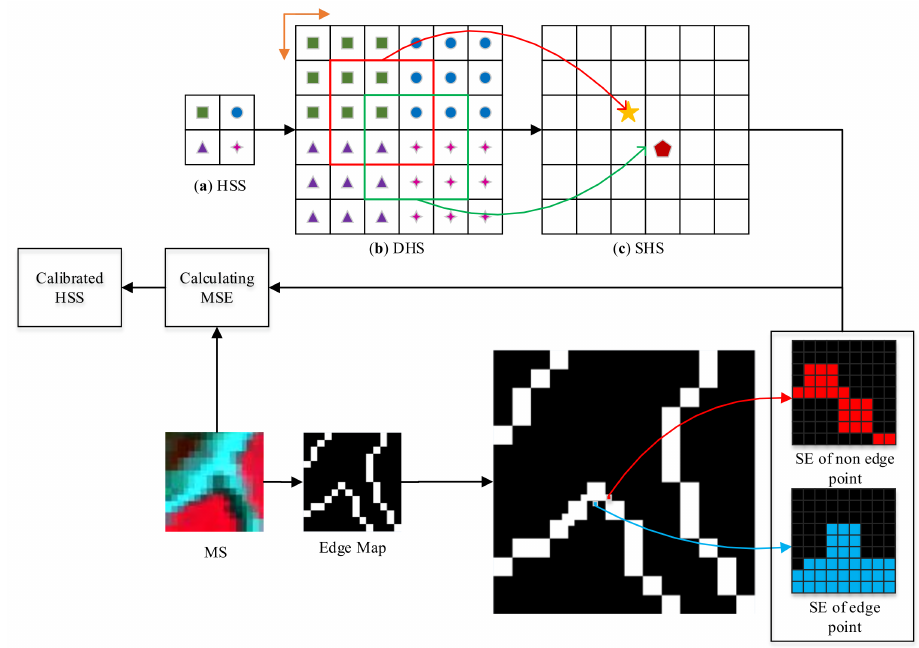
Figure 3. The schematic of subpixel spatial calibration